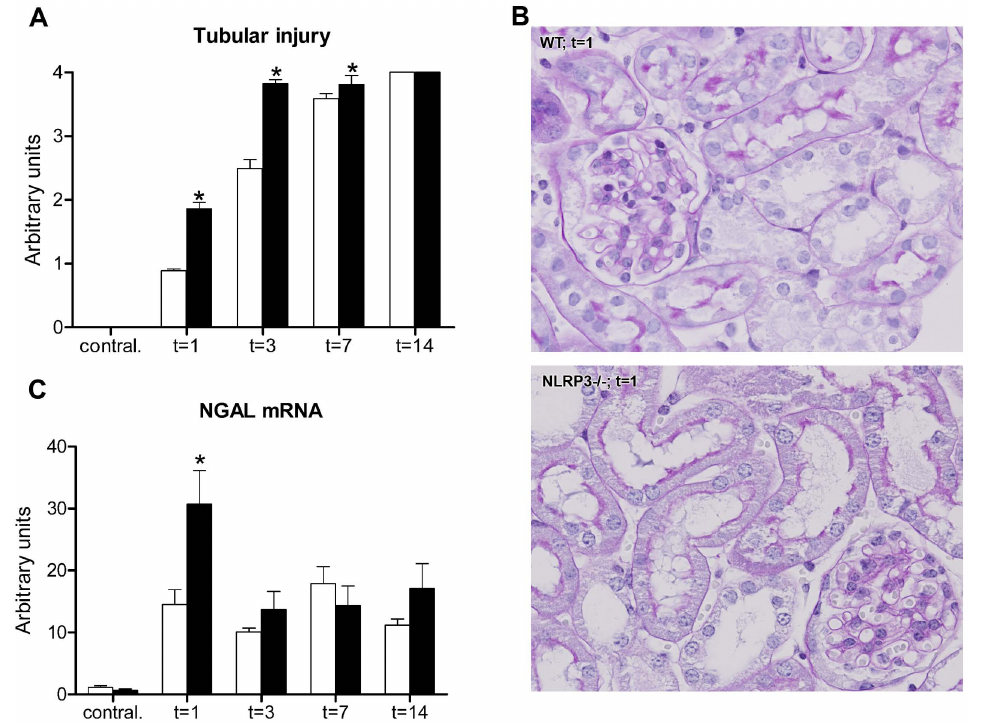
Figure 2. Nlrp3 deficiency increases renal injury following UUO. (A) Semi-quantitative tubular injury score in wild type (white bars) and Nlrp3 2 / 2 (black bars) mice following UUO. Nlrp3 2 / 2 mice developed significantly more tubular injury when compared to their respective wild type mice 1, 3, and 7 days post-UUO. (B) Representative PASD microphotographs of renal tissue subjected to 1 day of UUO, with apparent interstitial edema in the Nlrp3 2 / 2 kidneys (magnification x200). (C) Nlrp3 2 / 2 mice displayed enhanced mRNA expression of the renal injury biomarker NGAL compared to their wild type mice following UUO. Data are mean 6 SEM of 7 mice per group. Contral. = contralateral kidneys of mice subjected to 14 days of UUO. *:p ,